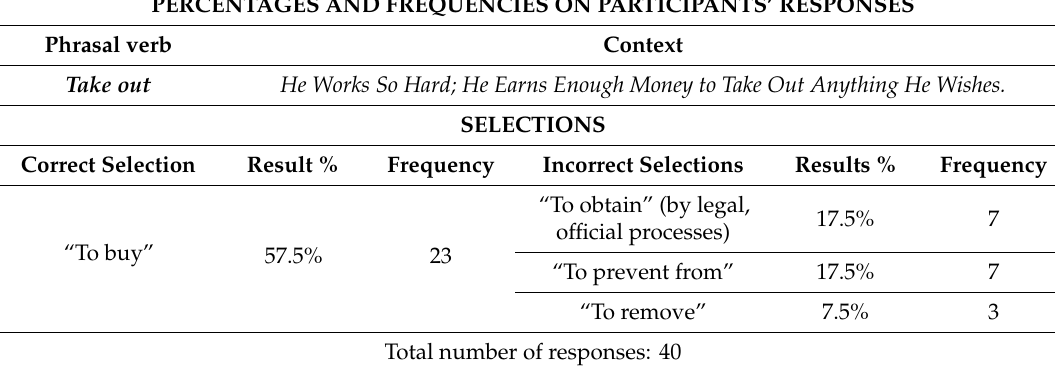
Table 6. Percentages and frequencies for take out .